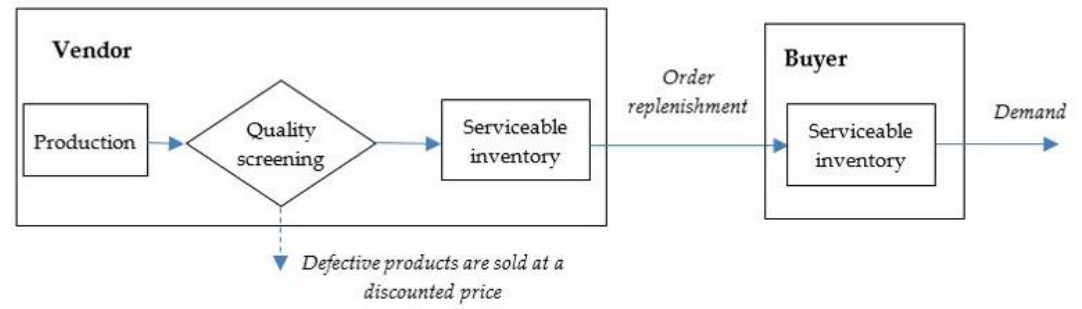
Figure 2. Illustration of an integrated inventory model for imperfect quality items with vendor’s inspection.